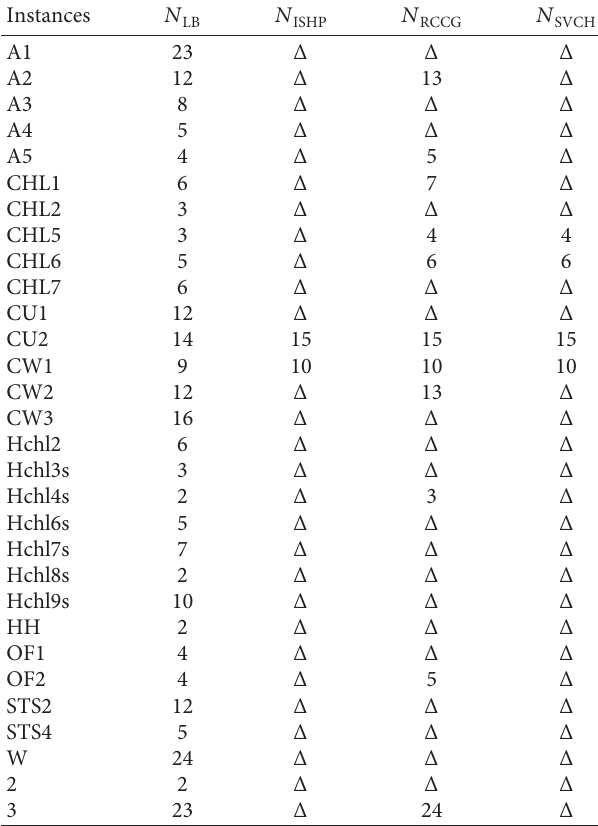
Table 2: Computational results for set A